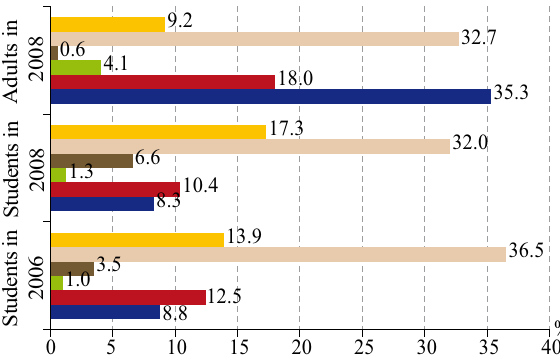
Fig. 8. Comparison of students and adults trips by